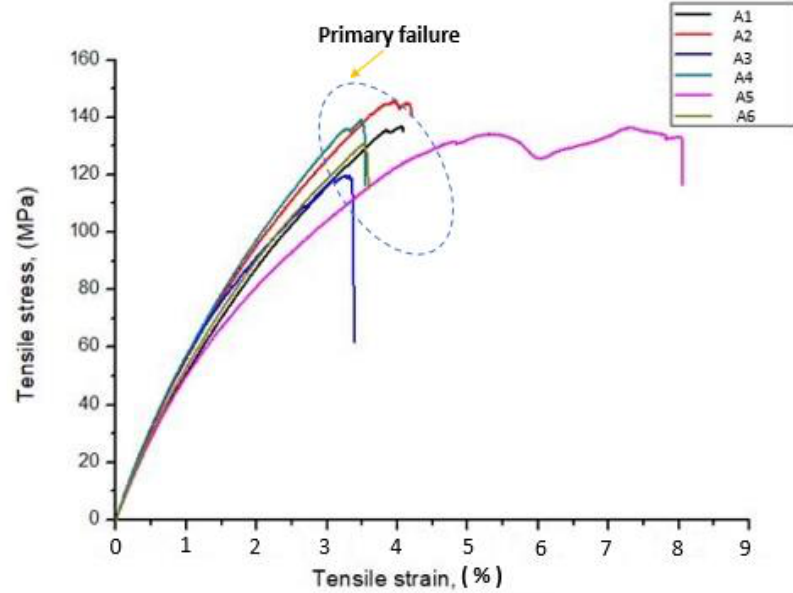
Figure 2. Stress Vs. strain variation of GF/SF/CTS composite scaffolds under tensile test.